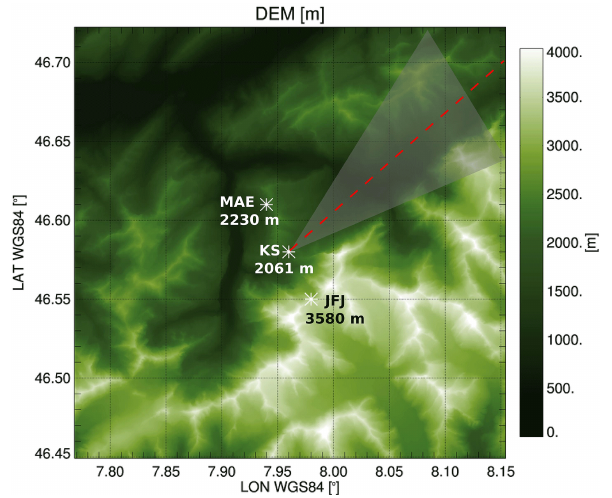
Figure 1. Location of the main measurement sites of CLACE 2014 that are considered here. The locations are highlighted on a digital elevation model of the area. The gray shading highlights the area of the domain covered by radar PPIs, while the red line indicates the direction of the RHI employed in the analysis of the paper. The coordinates shown on the map are expressed in the World Geodesic System 1984 (WGS84)